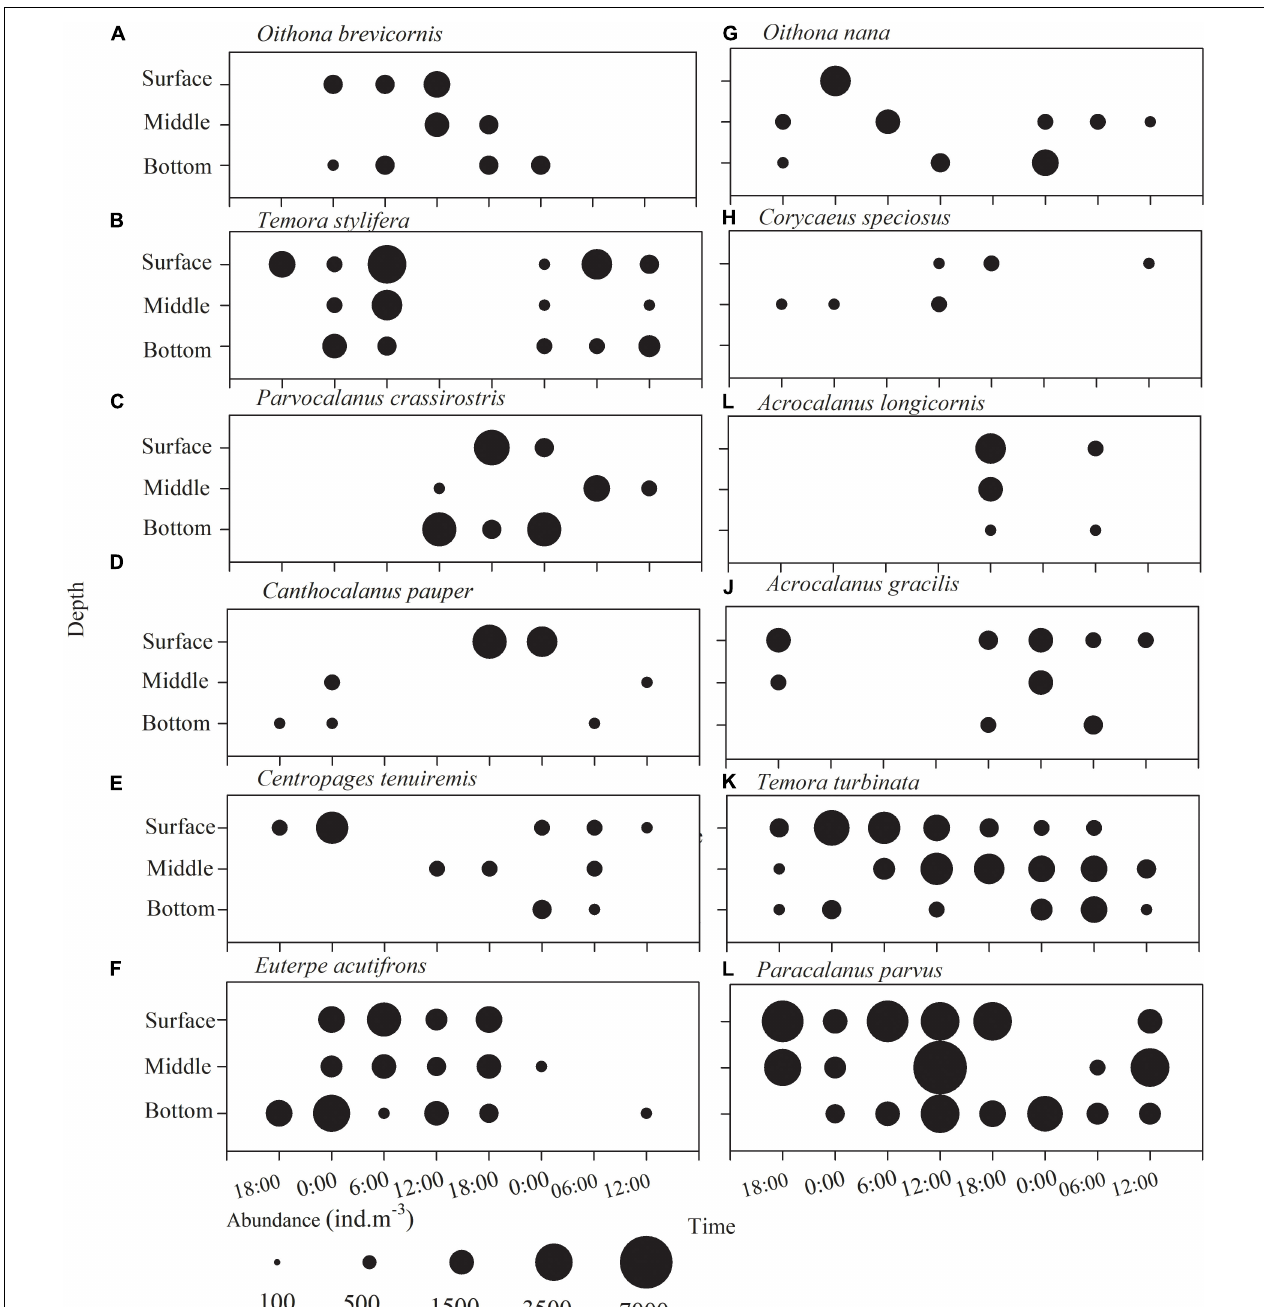
FIGURE 5 | Diurnal vertical distribution of the copepod species (A) Oithona brevisornis , (B) Temora stylifera , (C) Parvocalanus crassirostris , (D) Canthocalanus pauper , (E) Centropages tenuiremis , (F) Euterpe acutifrons , (G) Oithona nana , (H) Corycaeus speciosus , (I) Acrocalanus longicornis , (J) Acanthorhodeus gracilis , (K) Temora turbinata , and (L) Paracalanus parvus in Daya Bay during September 30 to October 2, 2014.